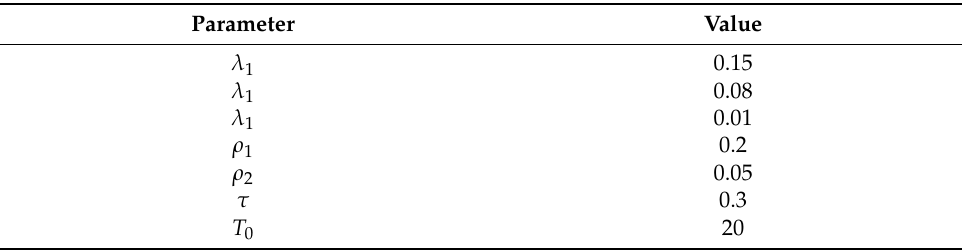
Table 3. The value of parameter in the theoretical